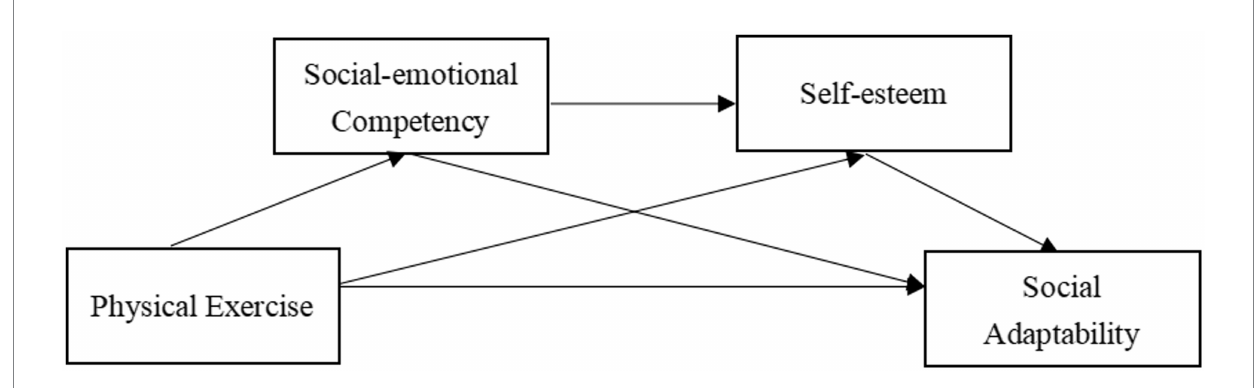
FIGURE 1 The hypothetical structure